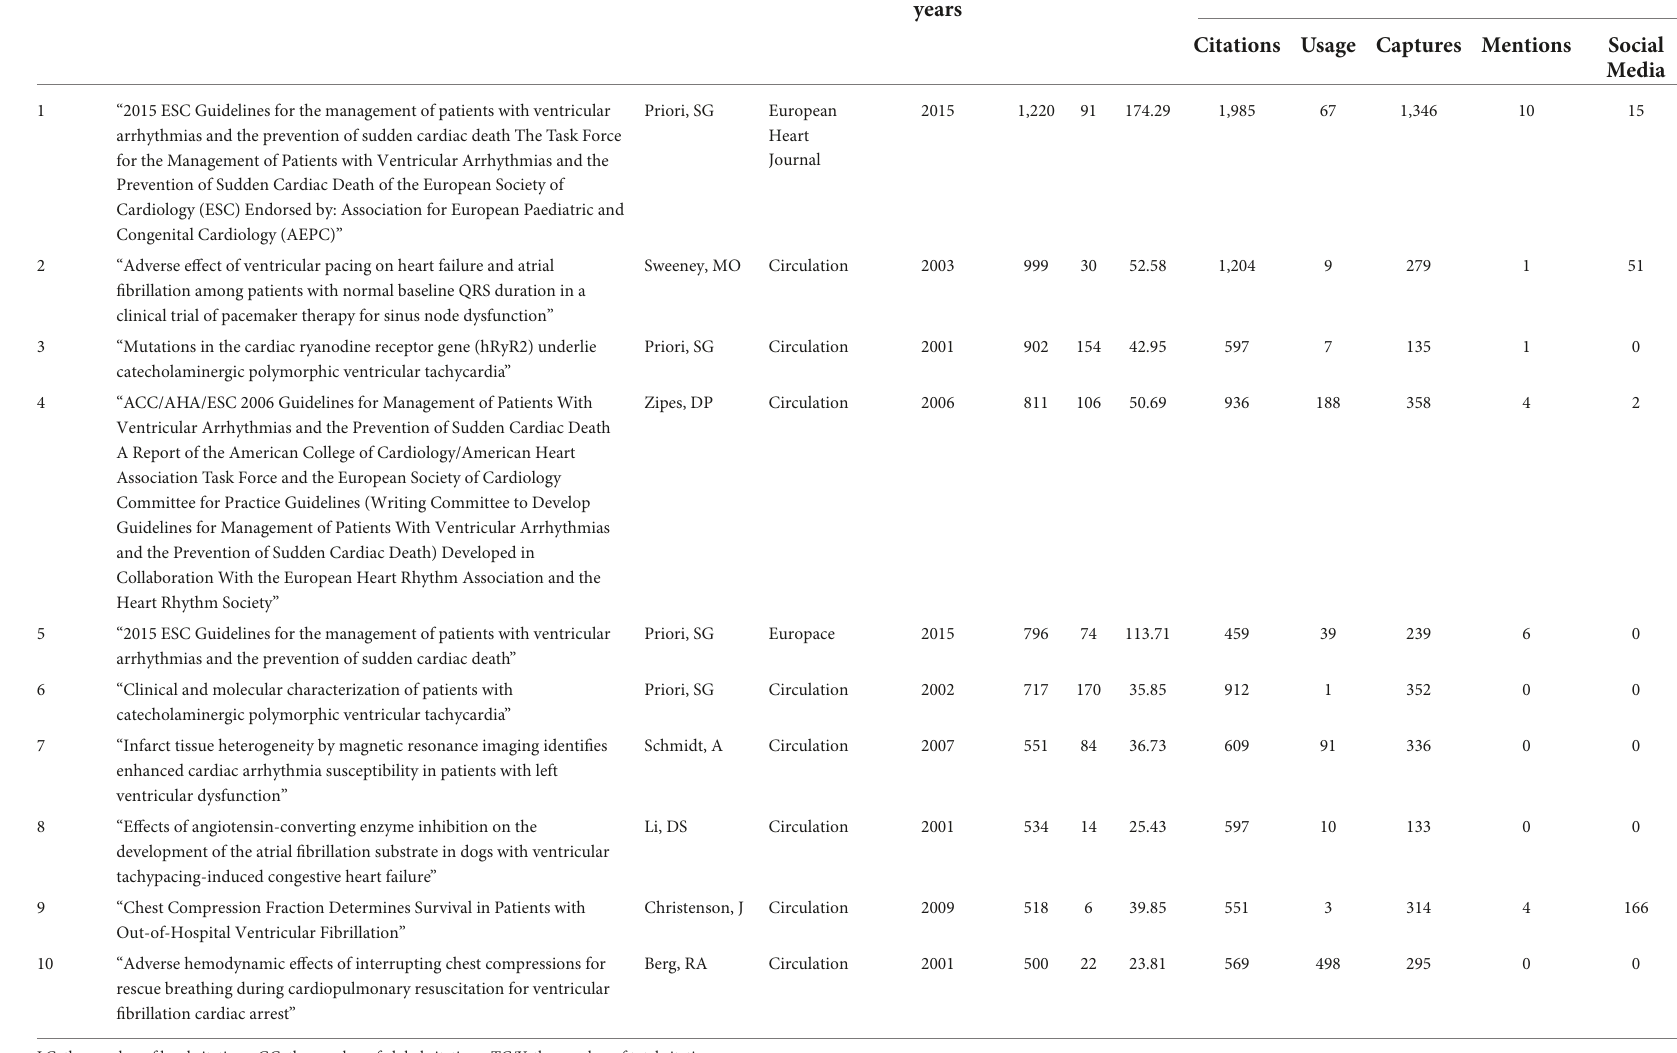
TABLE 5 The top 10 most global popular articles and their bibliometric parameters (ordered by the number of global citations). Rank